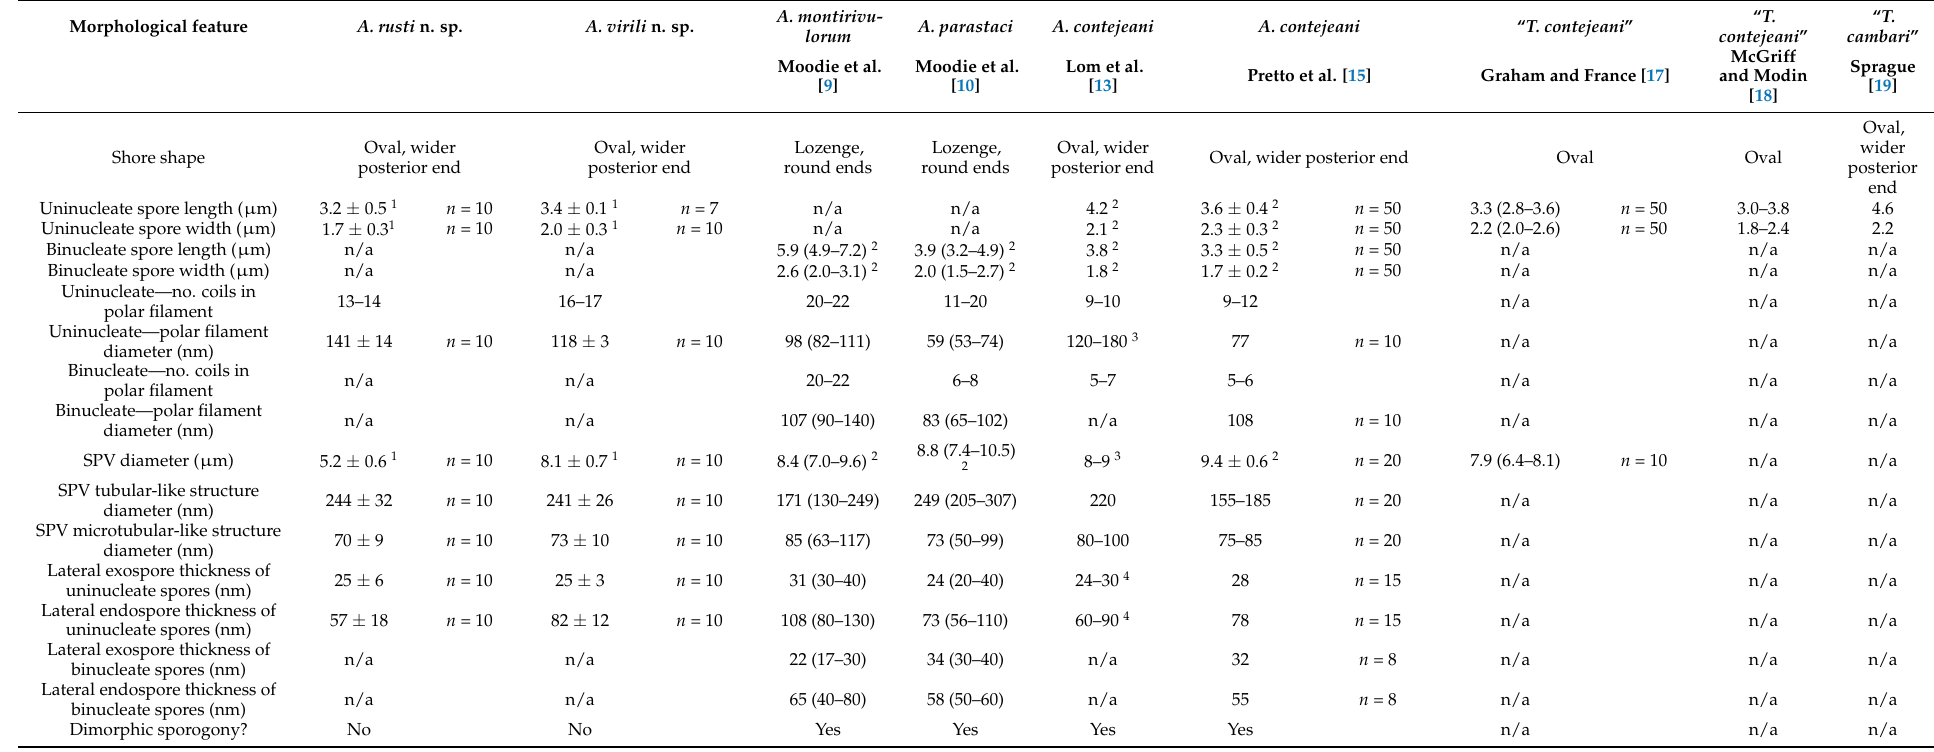
Table 2. Comparison of morphological features of all described Astathelohania (previously Thelohania ) species. In addition, the morphological features of two suspected and an unofficial Thelohania in North America are included. The table was adapted from Moodie et al. [9], n/a indicates data were not